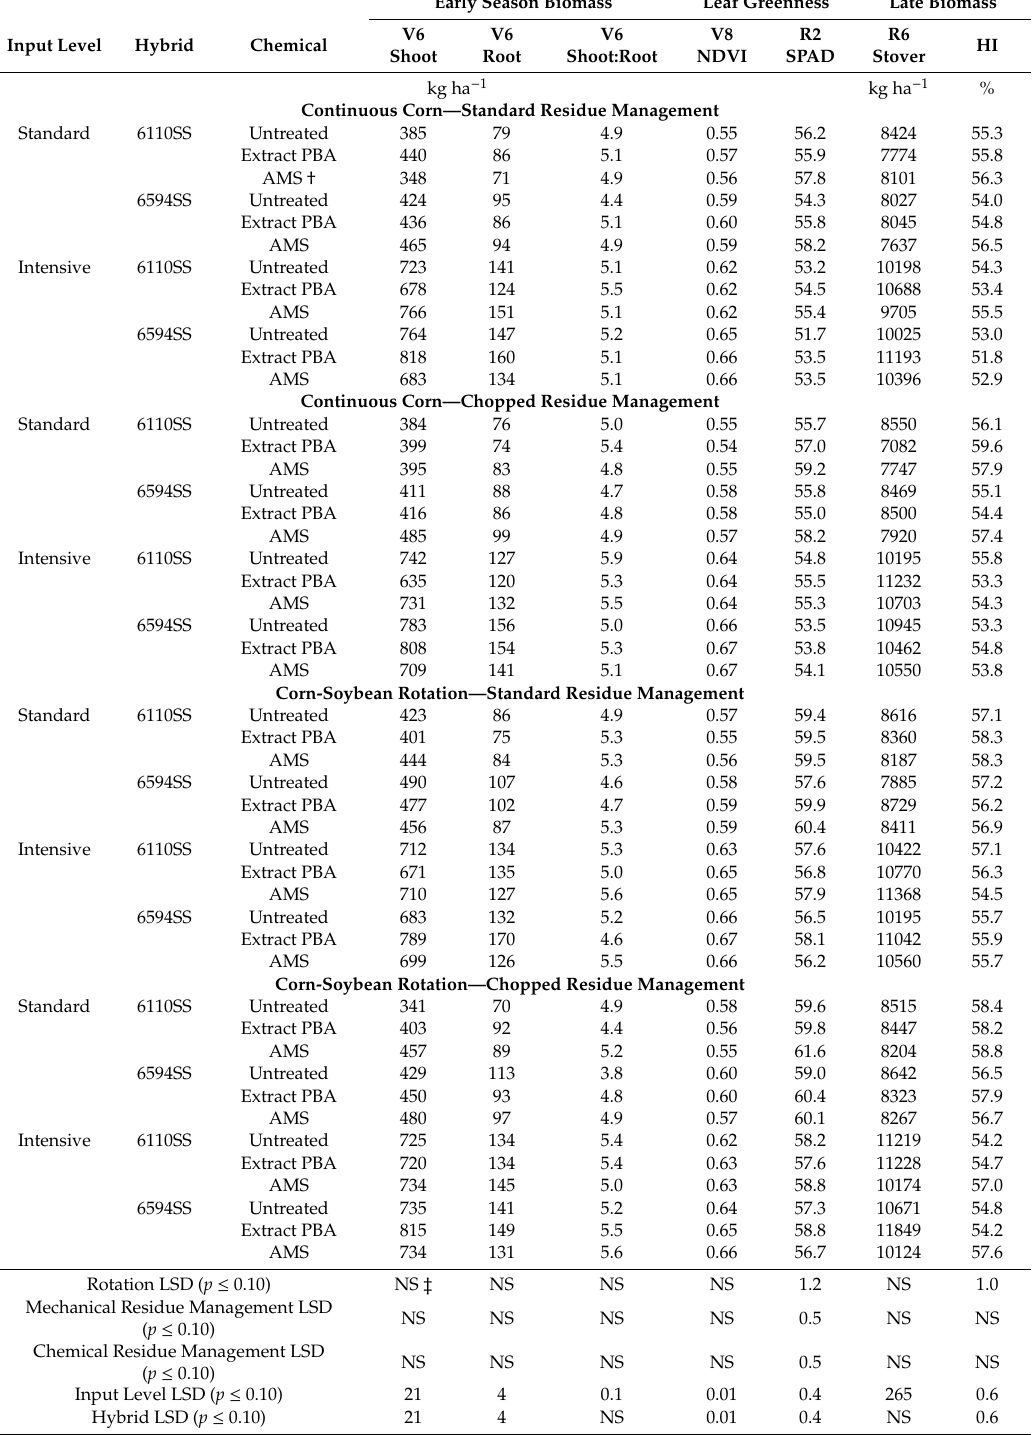
Table 6. Above- and below-ground biomass accumulation, plant greenness, and harvest index (HI) as influenced by crop rotation, mechanical and chemical residue management, agronomic input level, and hybrid at various plant growth stages (V6, V8, R2, and R6) for corn grown at Champaign, IL during 2017 and 2018. All values are reported at 0 g kg − 1 moisture